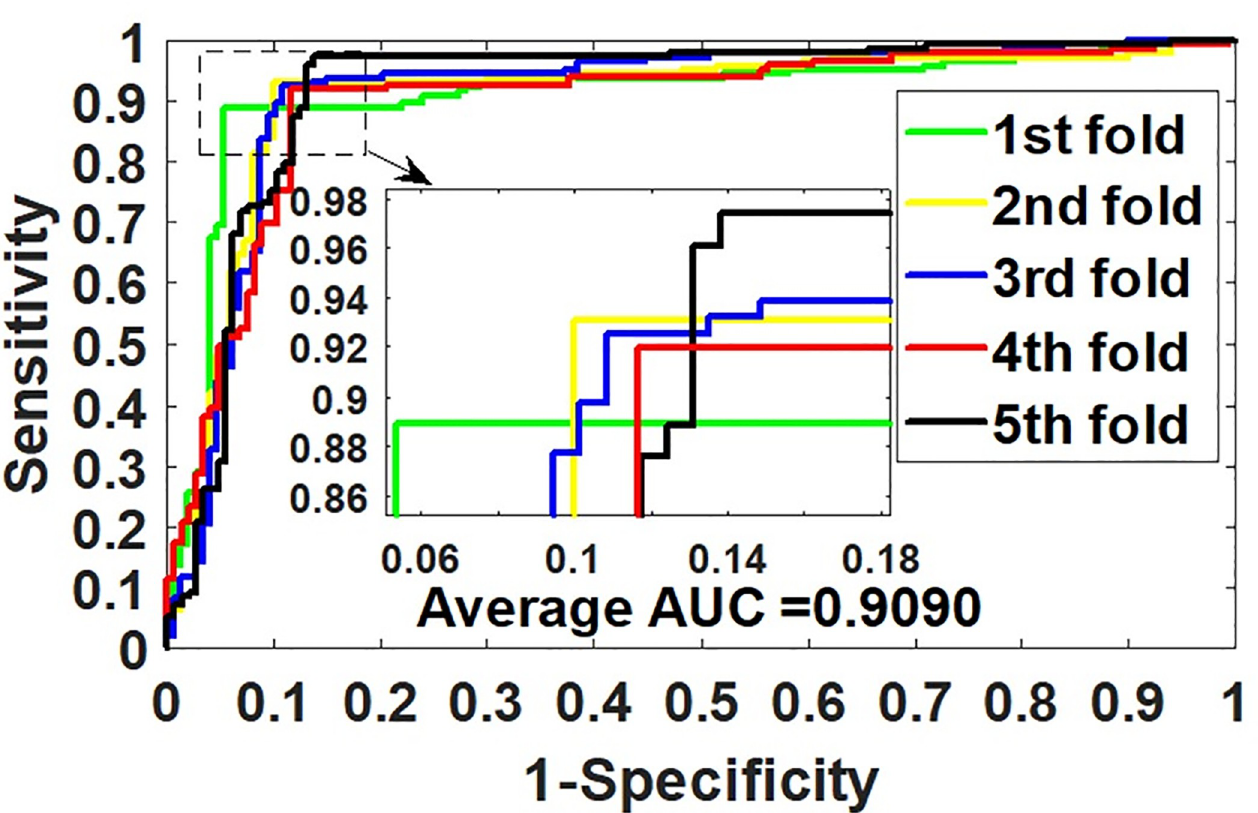
Fig 1. ROC curves of 5-fold CV obtained by GCNCDA on circR2Disease dataset.